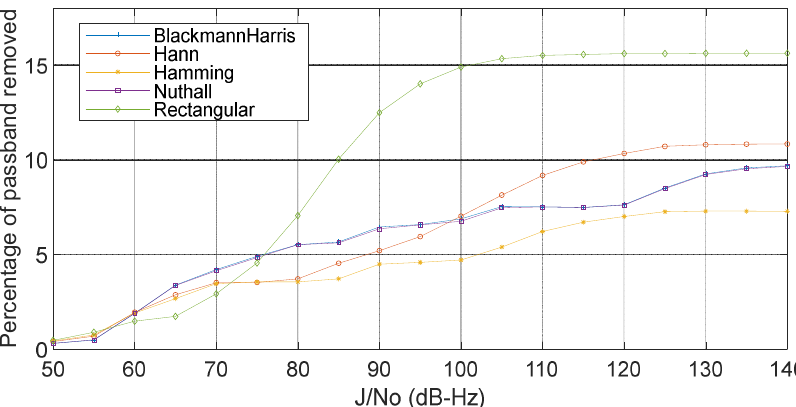
Figure 10. Amount of spectrum (passband) removed by the filter with a single jammer (55 kHz from the centre frequency, PRN Doppler = 700 Hz) with different windowing functions .